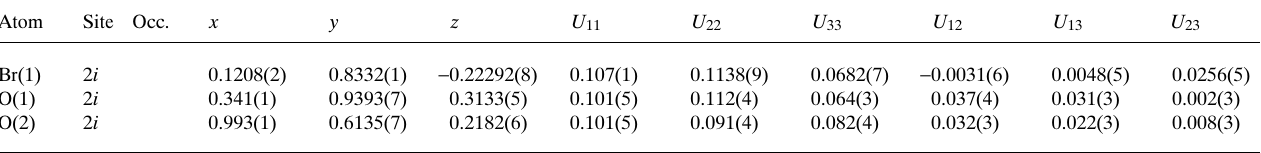
Table 3. Atomic coordinates and displacement parameters (in Å 2 )